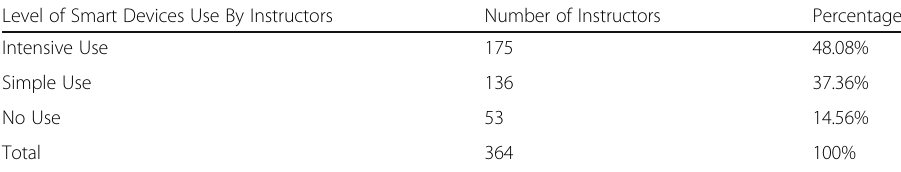
Table 3 Level of smart devices use by instructors themselves whether inside or outside classroom Level of Smart Devices Use By